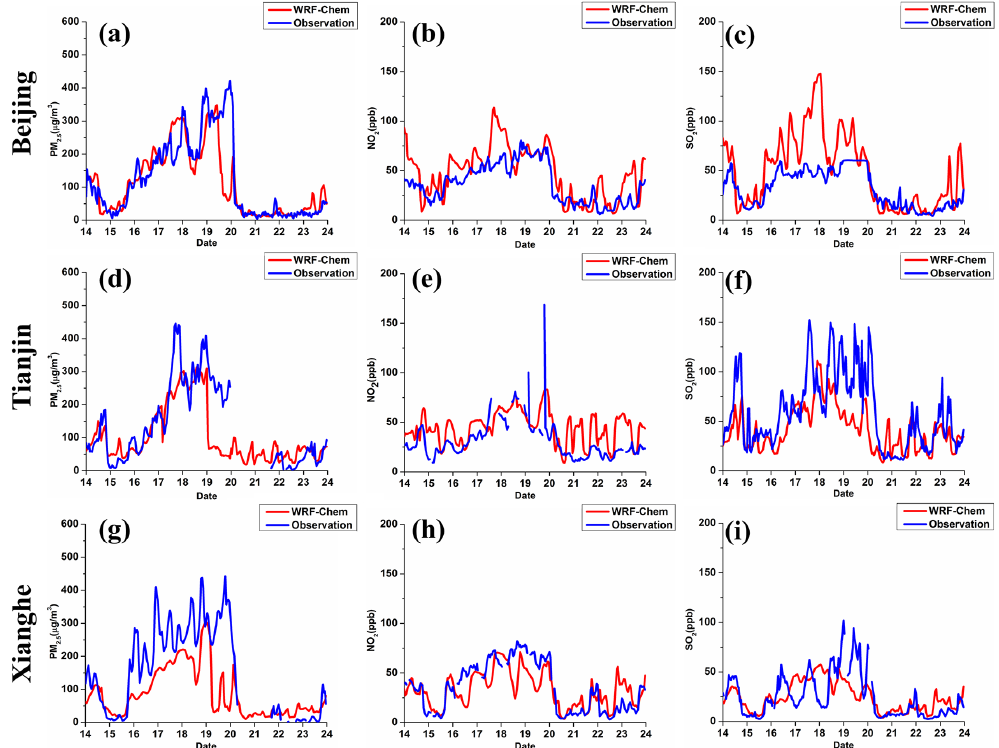
Figure 4. Temporal variations of the simulated and observed PM 2 . 5 , NO 2 and SO 2 at Beijing (a–c) , Tianjin (d–f) and Xianghe (g–i)